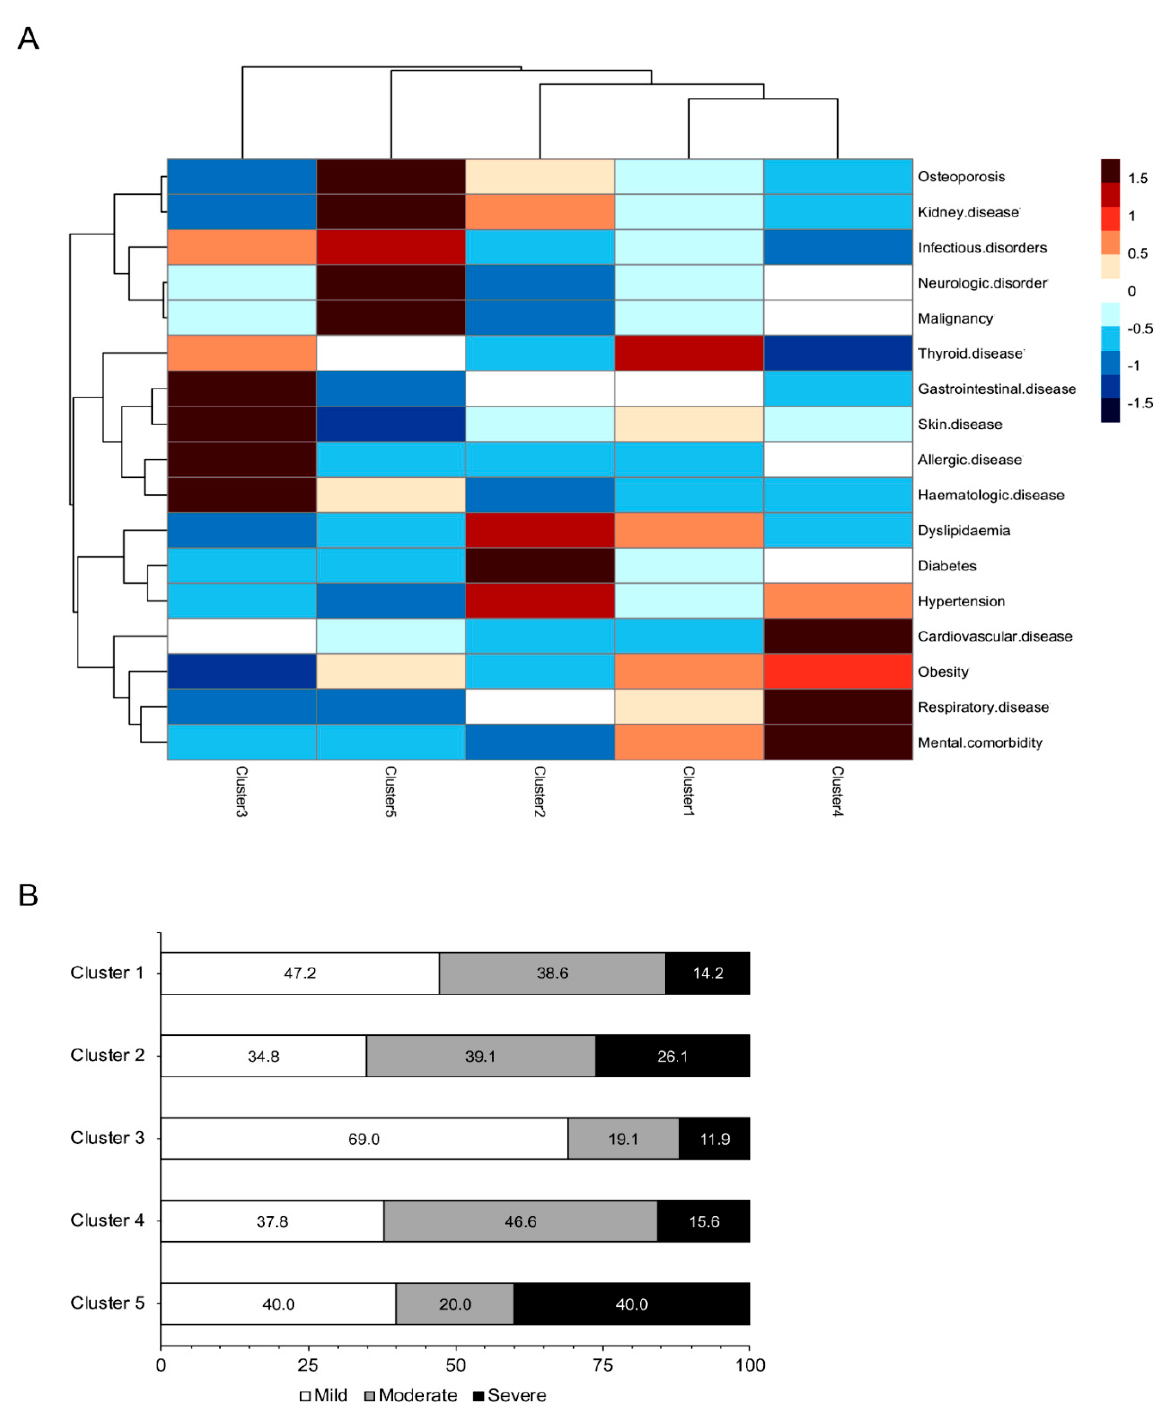
Figure 2. Distinct comorbidities phenotypes in patients with SLE revealed by cluster analysis. ( A ) Utilizing Gower’s distance and complete linkage method, hierarchical agglomerative clustering of the patients according to their comorbidity profile was performed. The chi-squared statistic was used to examine whether the distribution of the comorbidities differed between the identified patient clusters. The heatmap of the frequencies of comorbidities groups across the patient clusters is shown. Legend depicts the relative frequency (ranging from − 1.5 to +1.5) of each comorbidity within each cluster. ( B ) Prevalence of SLE severity patterns (mild, moderate, severe) based on the BILAG system across the identified comorbidities clusters (cluster 1 to 5). Numbers are proportions